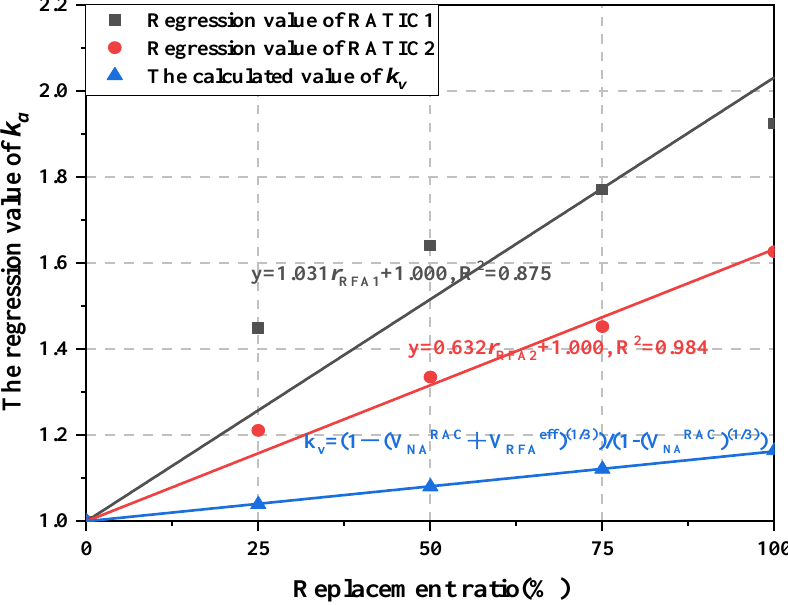
Figure 13. The regression value of k a and empirical value k v .